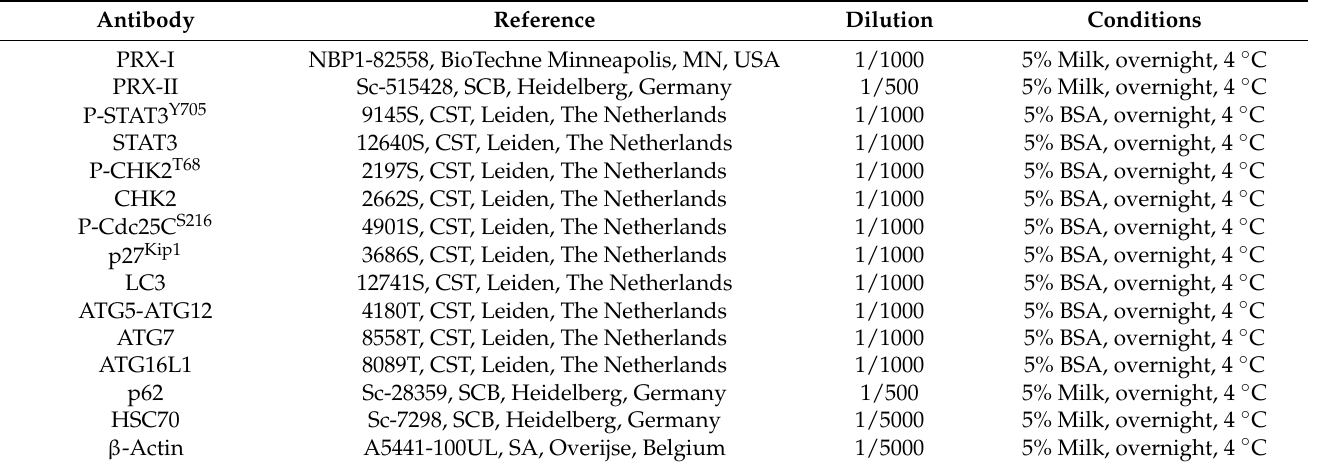
Table 1. Antibodies used in Western blot experiments. SCB: Santa Cruz Biotechnology, CST: Cell Signaling Technology, SA: Sigma Aldrich, BSA: bovine serum